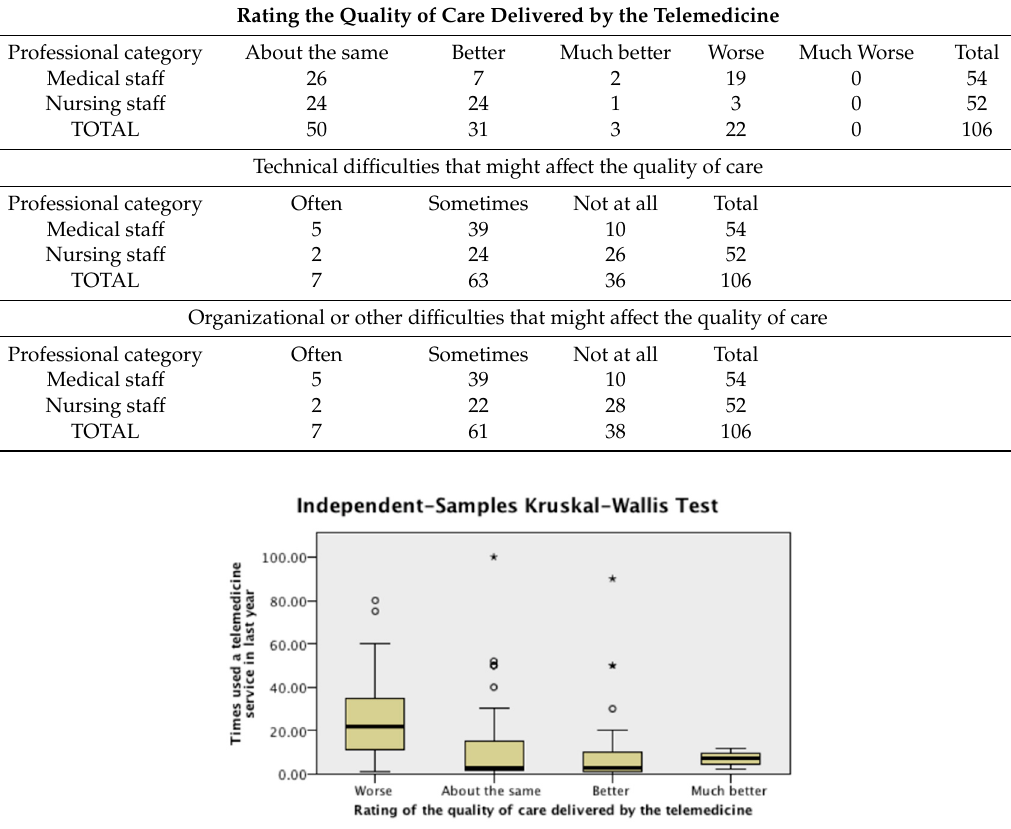
Figure 3. Quality of Care of the Telemedicine Consultation, by Number of Times Used.